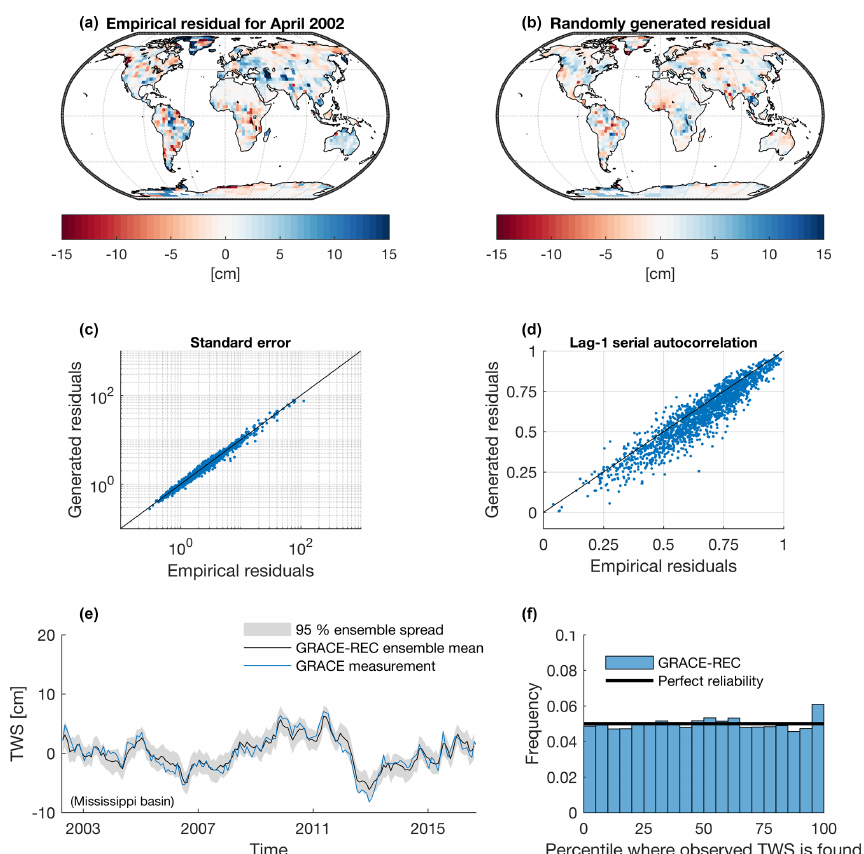
Figure 4. Output of the SAR model for the generation of random noise realizations that have a spatiotemporal structure similar to that of the empirical model residuals (for the GRACE-REC product based on MSWEP and calibrated with JPL mascons). (a) Empirical model residual at a given time step. (b) Residual randomly generated by the SAR model. (c) Agreement between the standard deviation of the empirical versus generated residuals (each point represents one mascon). (d) Agreement between the lag-1 autocorrelation of the empirical versus generated residuals (each point represents one mascon). (e) Illustration of the resulting ensemble spread for a basin-scale average. (f) Rank histogram using 5% bins, combining the data for 90 large ( > 500000km 2 ) basins (from 2003 to 2014), used to evaluate the reliability of ensemble forecasts.